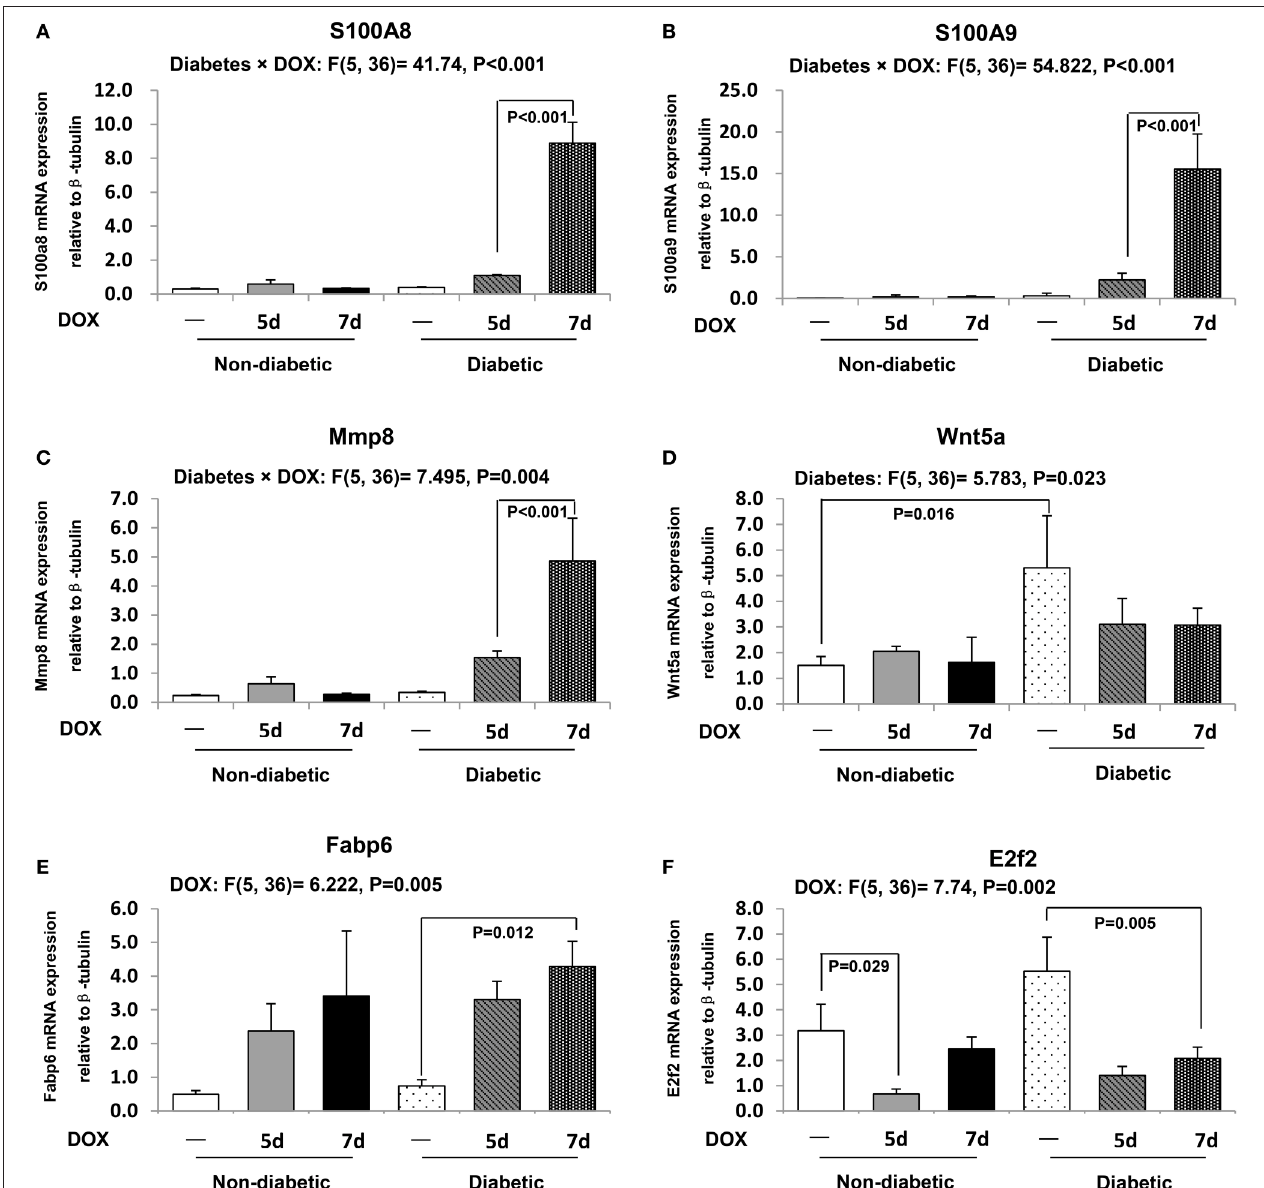
FIGURE 3 | Transcript expressions of selected genes from microarray results. The transcript expressions of S100A8 (A) , S100A9 (B) , Mmp8 (C) , Wnt5a (D) , Fabp6 (E) , and E2f2 (F) were examined by real time RT-PCR. Data are presented as expression ratio normalized to β -tubulin gene. Data are expressed as mean ± SEM ( n = 6 per group). Two-way ANOVA indicated a significant interaction effect between the two experimental factors (i.e., diabetes and DOX treatment) in S100A8 ( P < 0.001, F = 41.74), S100A9 ( P < 0.001, F = 54.822), and Mmp8 ( P = 0.004, F = 7.495; A–C ). A significant main effect of the factor diabetes was found in Wnt5a ( P = 0.023, F = 5.783; D ). A significant main effect of the factor DOX treatment was found in Fabp6 ( P = 0.005, F = 6.222), and E2f2 ( P = 0.002, F = 7.74; E,F ). Individual means were compared among groups by one-way ANOVA with Turkey’s HSD post-hoc